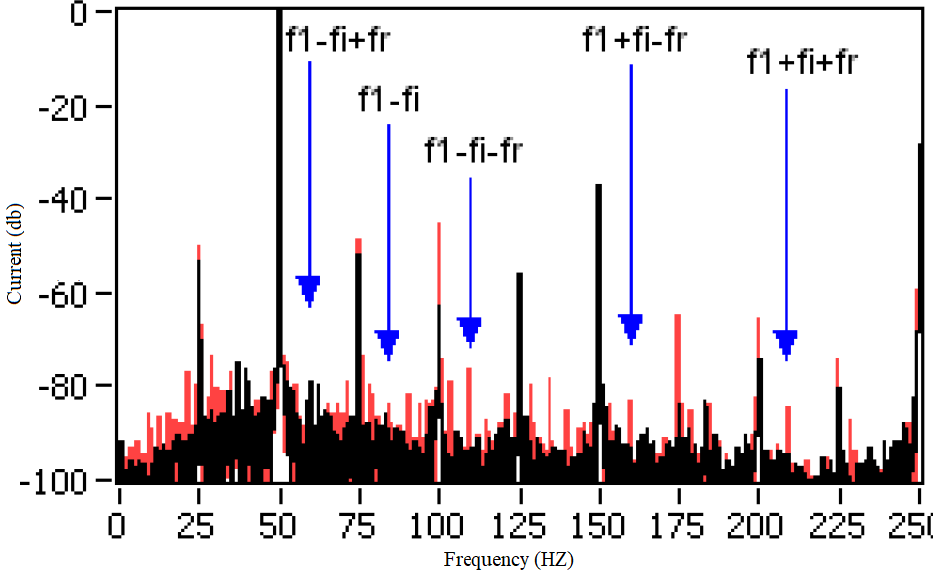
Figure 9. Magnetic stray flux spectrum for healthy bearing (black spectral lines) and inner raceway fault (red spectral lines) to diagnose bearing faults. Reproduced with permission of [26].